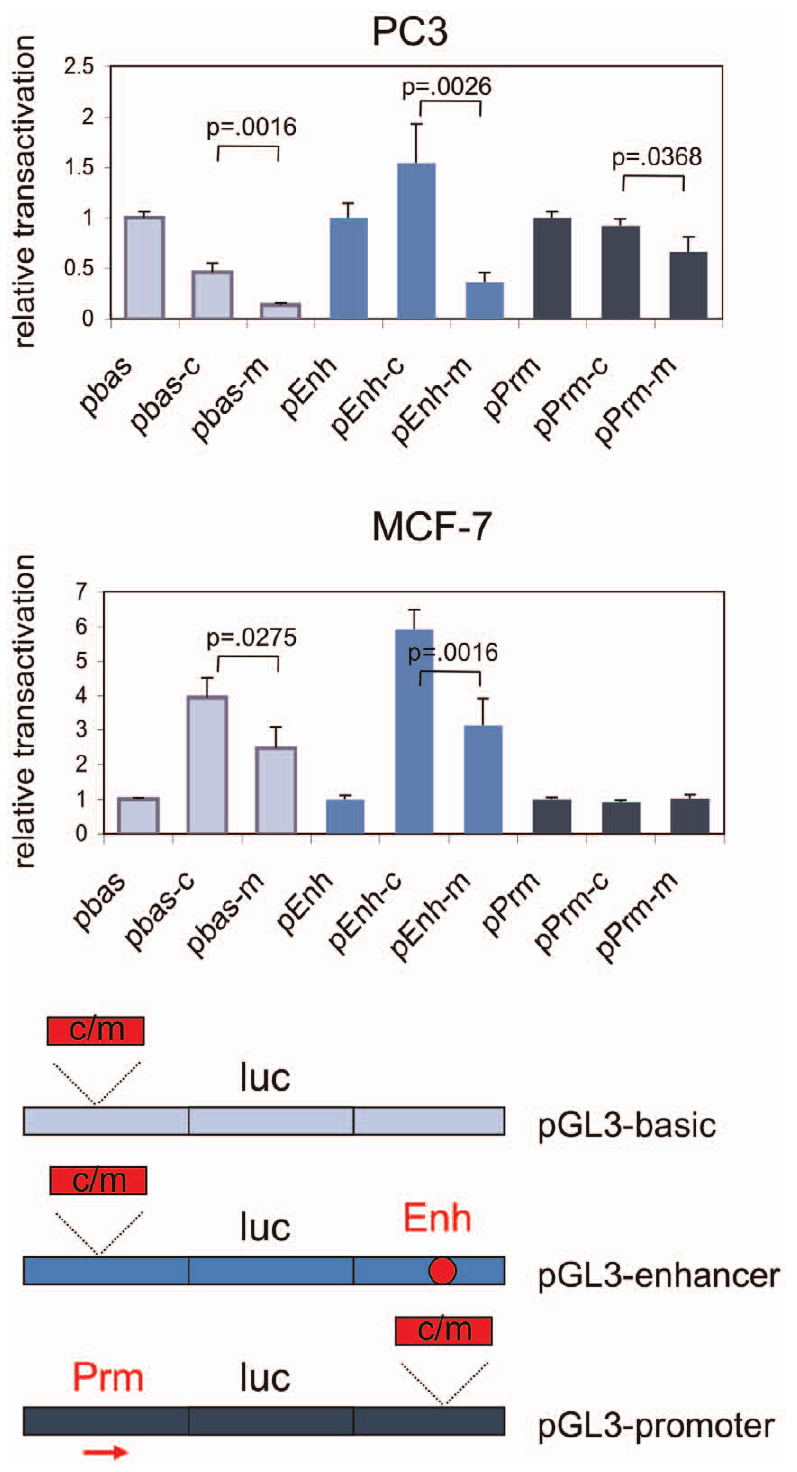
Figure 3. Relative transcriptional activation by the common and minor alleles of rs378854. The 395 bp fragment overlapping the S-DHS was cloned into pGL3-basic (pbas), pGL3-enhancer (pEnh) and pGL3-promoter (pPrm) and transcriptional activation of the reporter luciferase gene by the two alleles (common and minor) assayed in the PC3 prostate cancer and the MCF-7 breast cancer cell lines. Activation by the insert is given relative to the parental vector. Averages of six independent transfections are shown and the standard deviation for each data set is given in the bar chart. Where significant, p-values are given for a Student’s t-test comparing the values obtained with common versus the minor allele in each vector background.